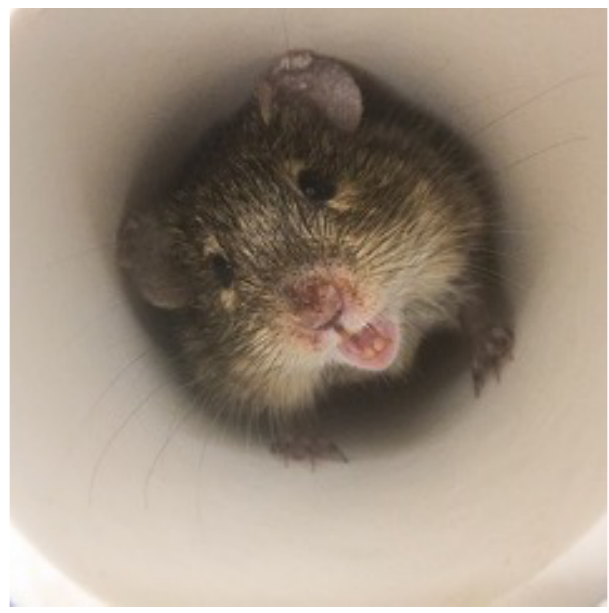
Figure 2. Nile rat in 2in polyvinyl chloride (PVC) tube for transfer.